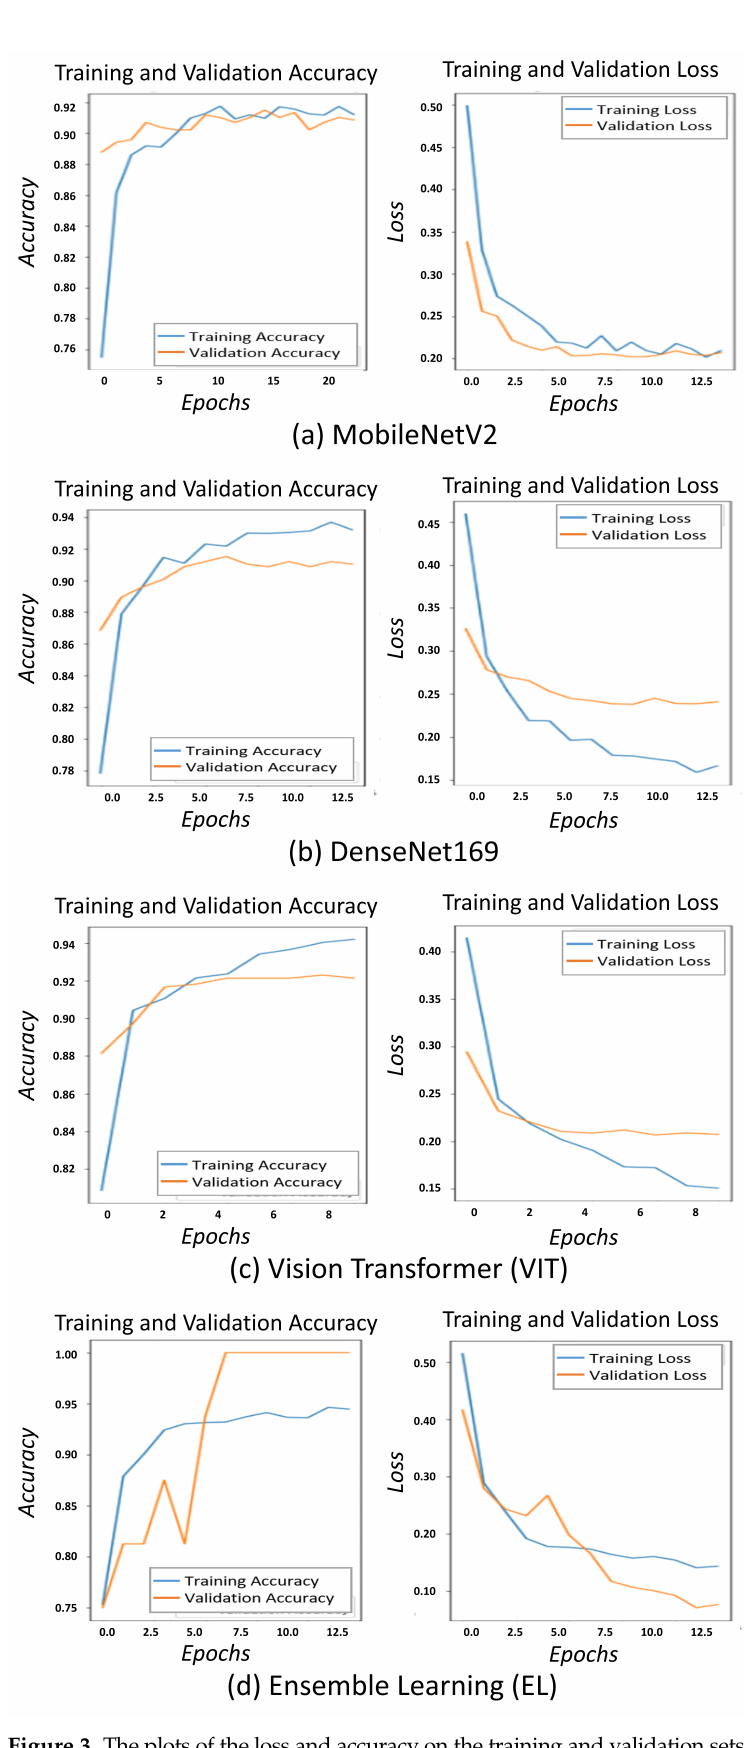
Figure 3. The plots of the loss and accuracy on the training and validation sets of the chest X-ray